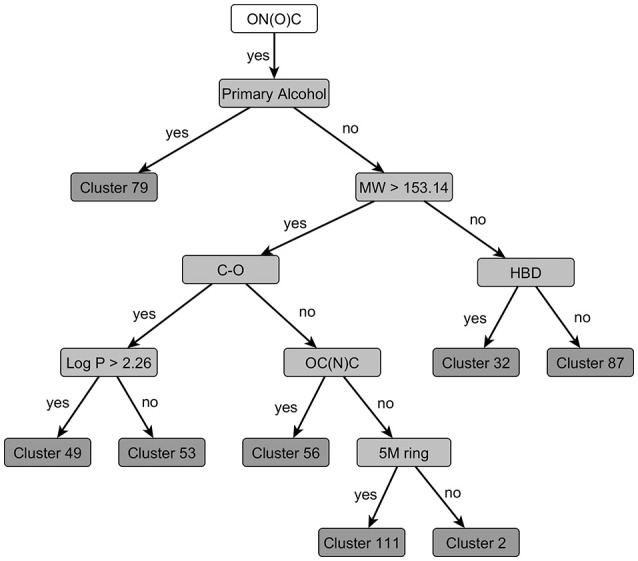
Decisions to be taken for clustering of nitro-group containing compounds [defined by the SMART-Code ON(O)C]. At each node the feature (structural feature, molecular weight, or log P) with the highest discriminative power is selected and the subsequent clusters are formed if their toxicity profiles are significantly different (p = 0.125). If no selective feature resulting in a significantly different toxic cluster can be identified, the clustering terminates by a final cluster, e.g., Cluster 49. The following structural features as defined in the OB FP4 list (O'Boyle et al., 2011) are used in this clustering tree: HBD, hydrogen bond donors; OC(N)C, Aliphatic O joined by any bond to C with joined with N and C; C-O, C-O single bond; 5M ring, any five-membered rings (the explanations for the SMARTS codes of the branches can be taken from the Supplementary Material).